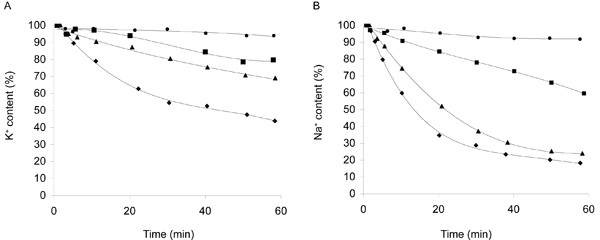
Efflux of cations from BW31a cells expressing various antiporters. The efflux of K+ (A) and Na+ (B) from BW31a cells harbouring the empty plasmid YEp352 (●) or expressing CdCnh1p (■), CpCnh1p (▲), CaCnh1p (♦) antiporters was measured. The initial concentrations of cations in cells (corresponding to 100%) were as follows: Na+, 110.5 ± 6.8 nmol (mg dry wt)-1, K+, 549.5 ± 25.7 nmol (mg dry wt)-1 (representative results are shown).